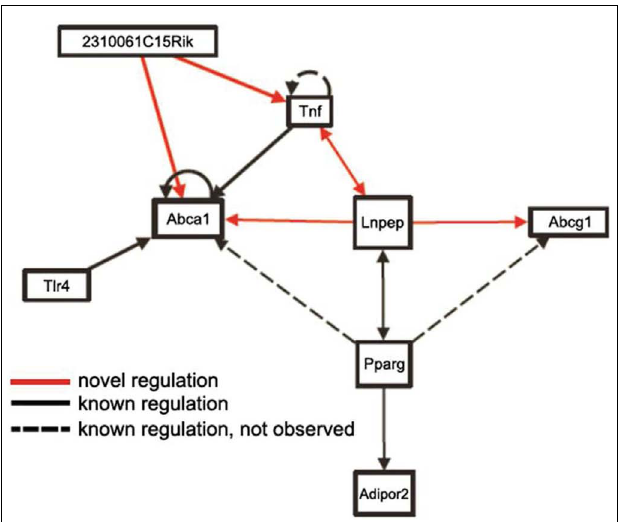
FIGURE 9 | Use of trans -eQTLs to identify novel gene-gene interactions .The expression data for macrophages in the HMDP data in the SGR were used to identify cis- and trans- acting eQTL genome-wide. Based on this, genes likely to contribute to the expression of other genes in trans were identified.This suggested a number of novel regulatory pathways (arrows shown in red) as well as known regulatory pathways (shown in solid lines). Some known regulatory pathways (dotted lines) were not observed, which is not unexpected since not all genes will exhibit common variation in the population. [Figure from Orozco et al. (2012) with